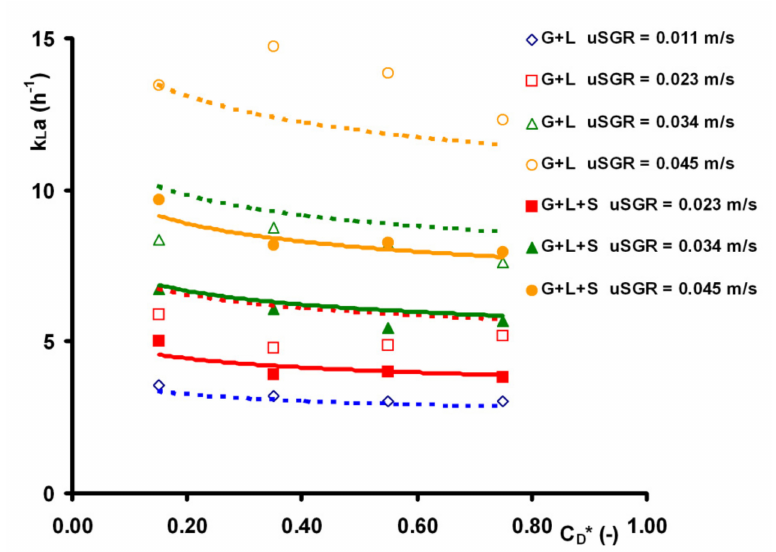
Figure 8. Overall volumetric mass transfer coefficient k L a : Effect of dimensionless deflector clearance: Gas–liquid system (empty symbols), gas–liquid–solid system (full symbols), correlation (12) for gas–liquid system (dotted line), correlation (12) for gas–liquid–solid system (full